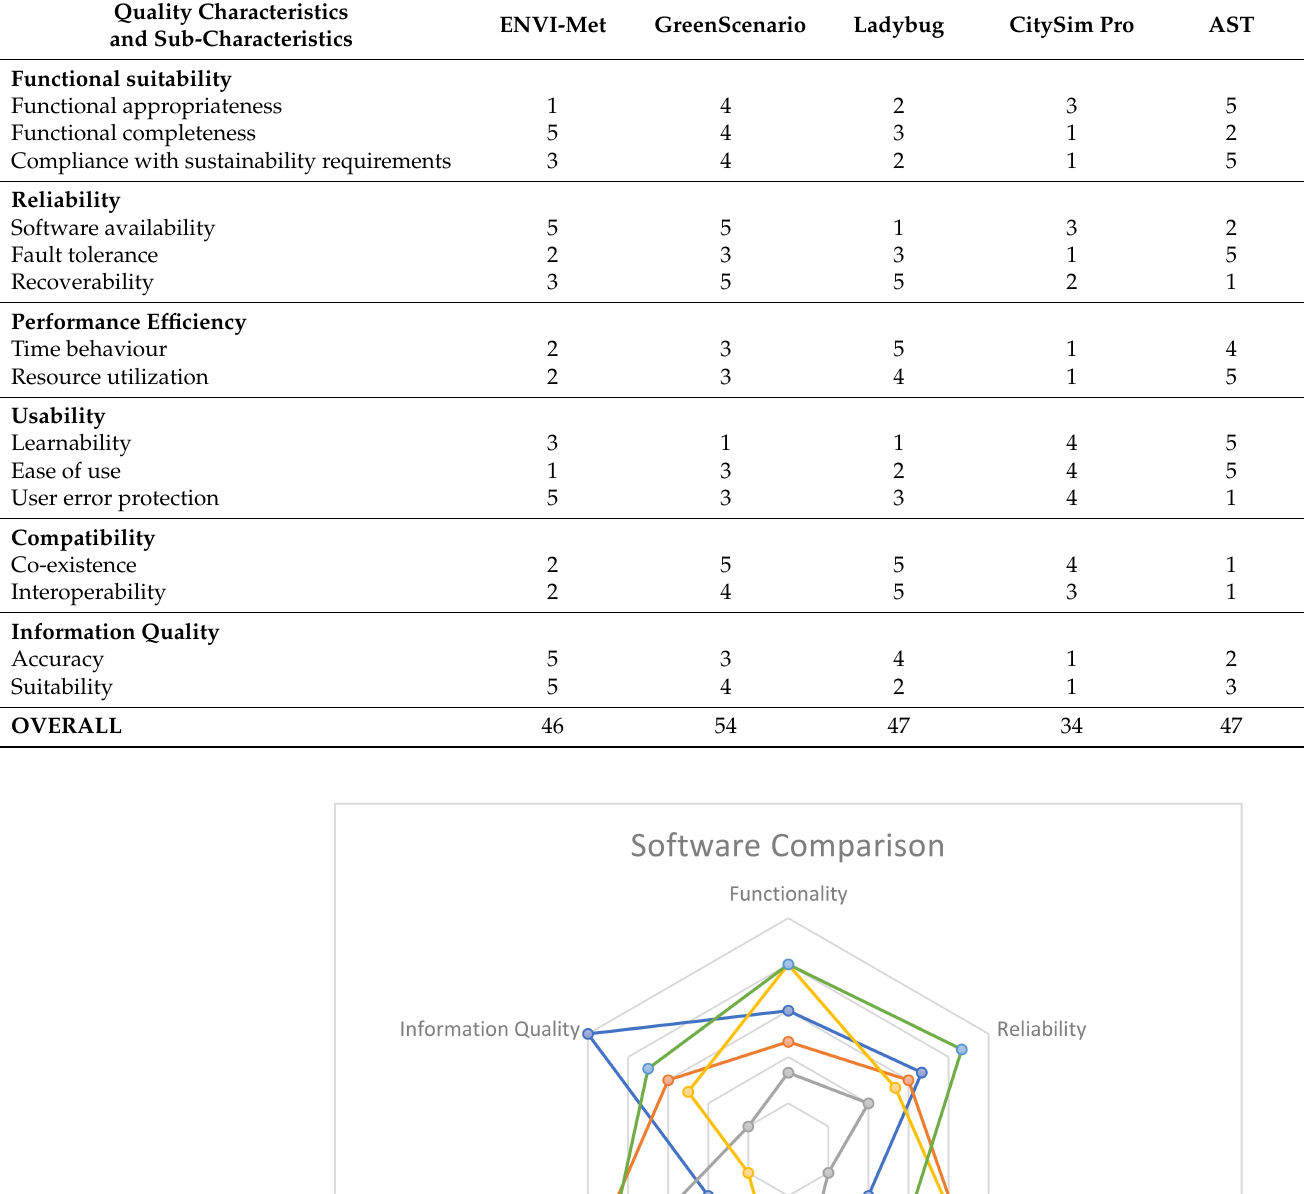
Table 6. Software evaluation based on ISO 25010 (source: authors).